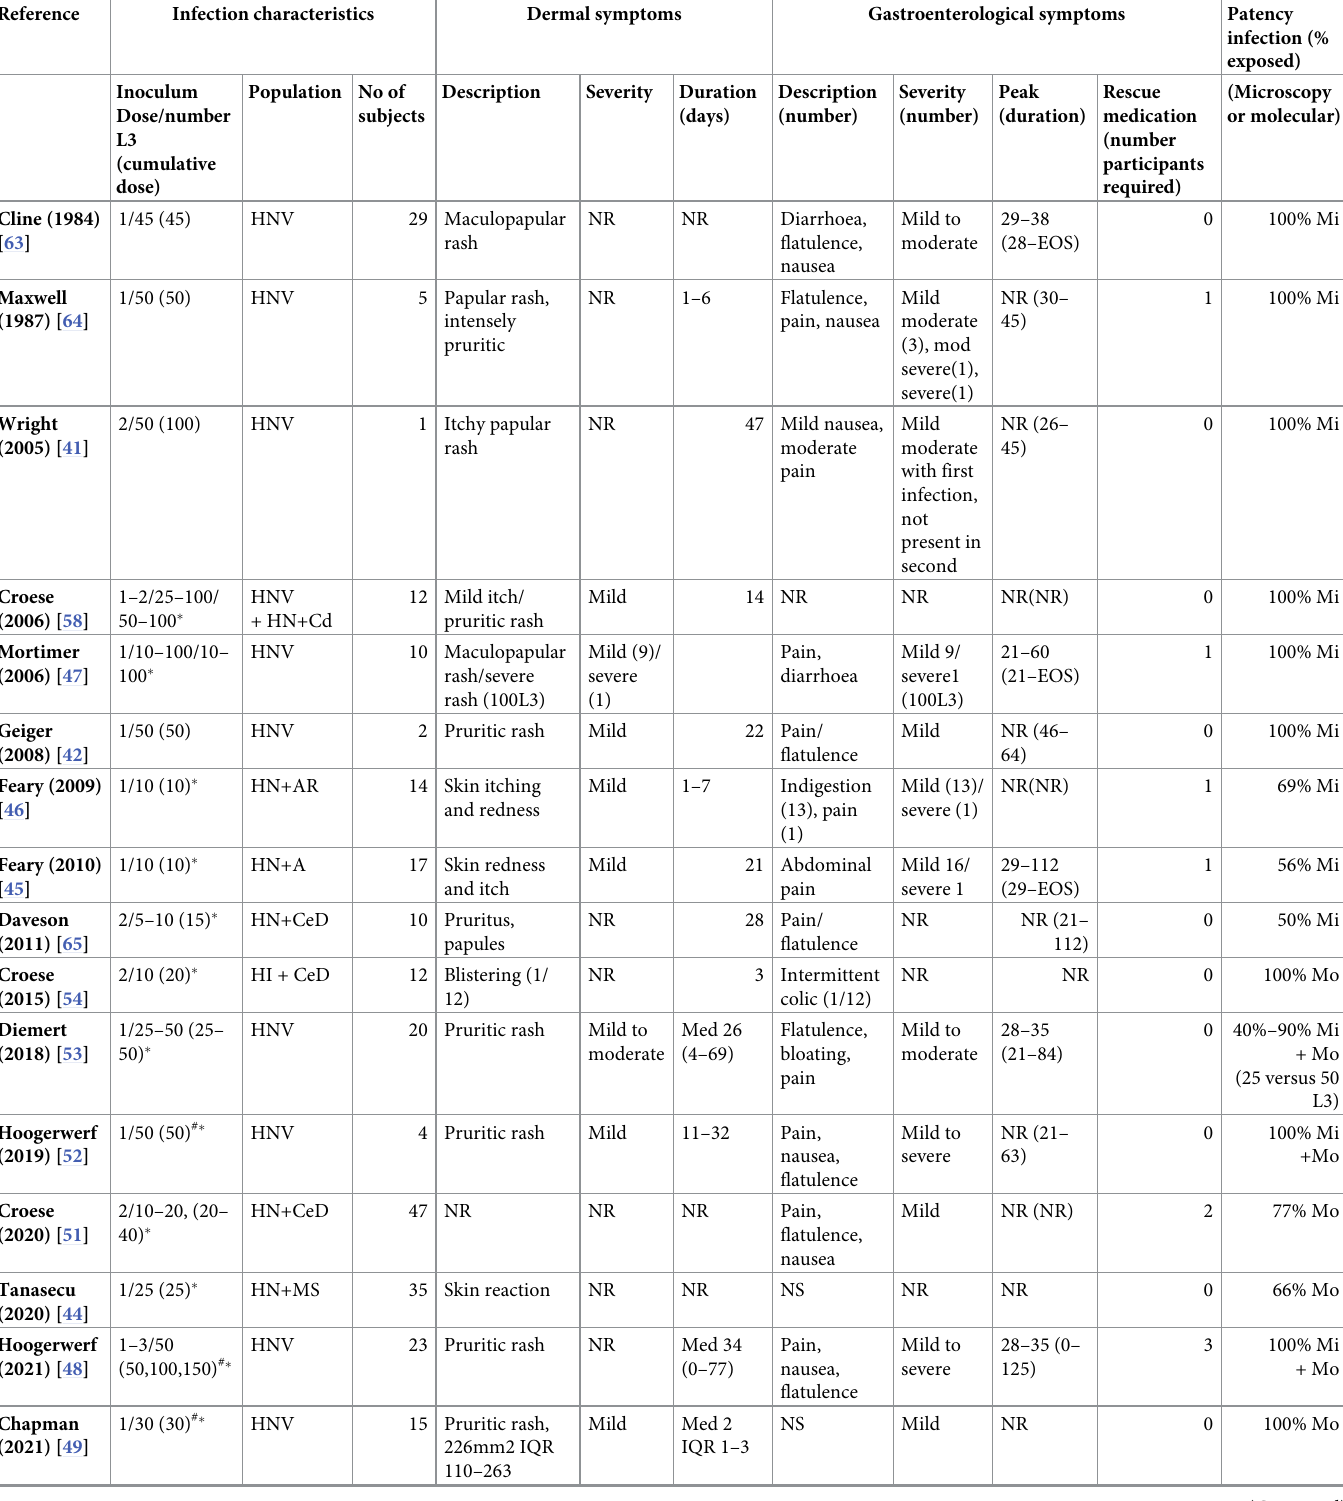
Table 1. Inoculation characteristics and adverse events reported in contemporary clinical trials of experimental infection with N . americanus